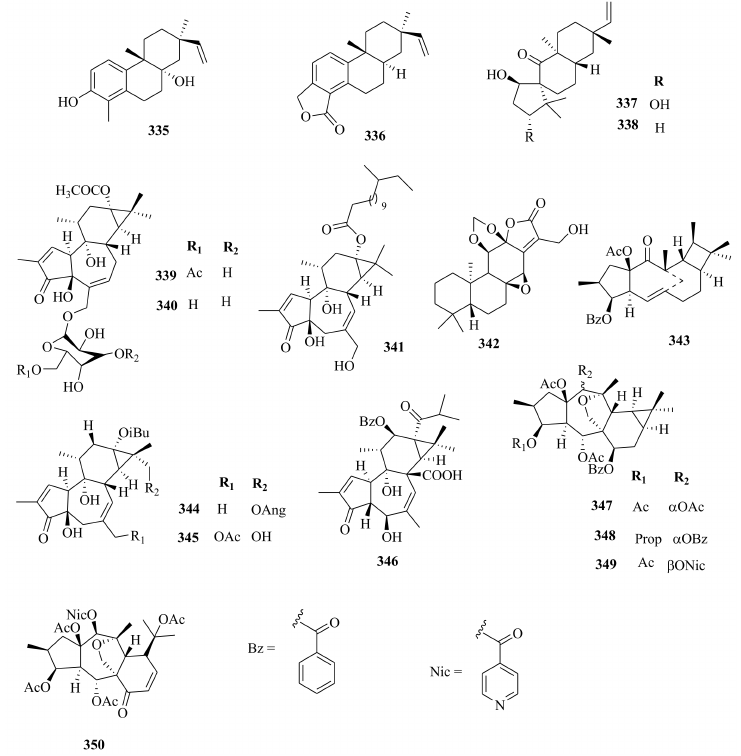
Figure 14. Continued: Mysrinane, premyrsinane, rosane and paralianone, pimarane, and tigliane